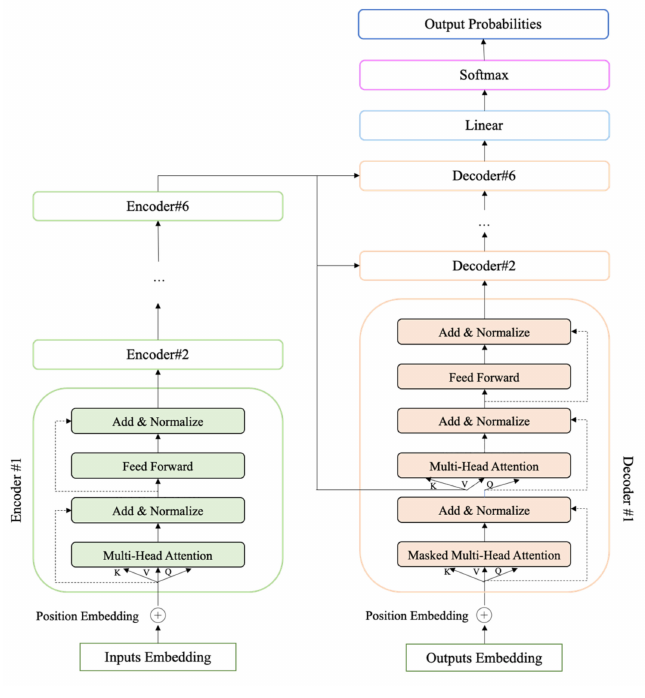
Figure 4. Baseline module [64].